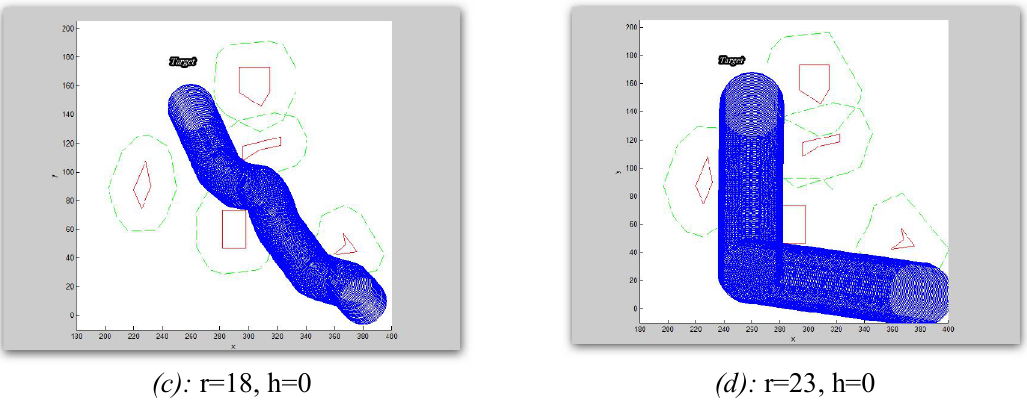
Fig. 8. Influence of robot’s radius (r) and safe distance (h) in quality of generated path